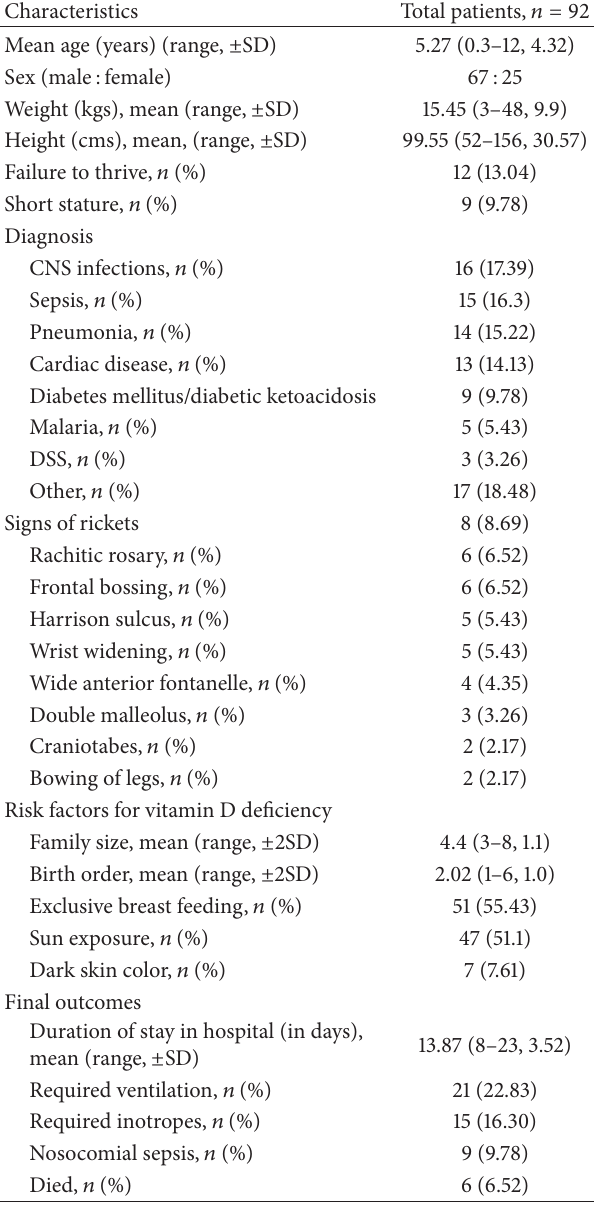
Table 1: Clinicodemographic characteristics and final outcomes of patients.